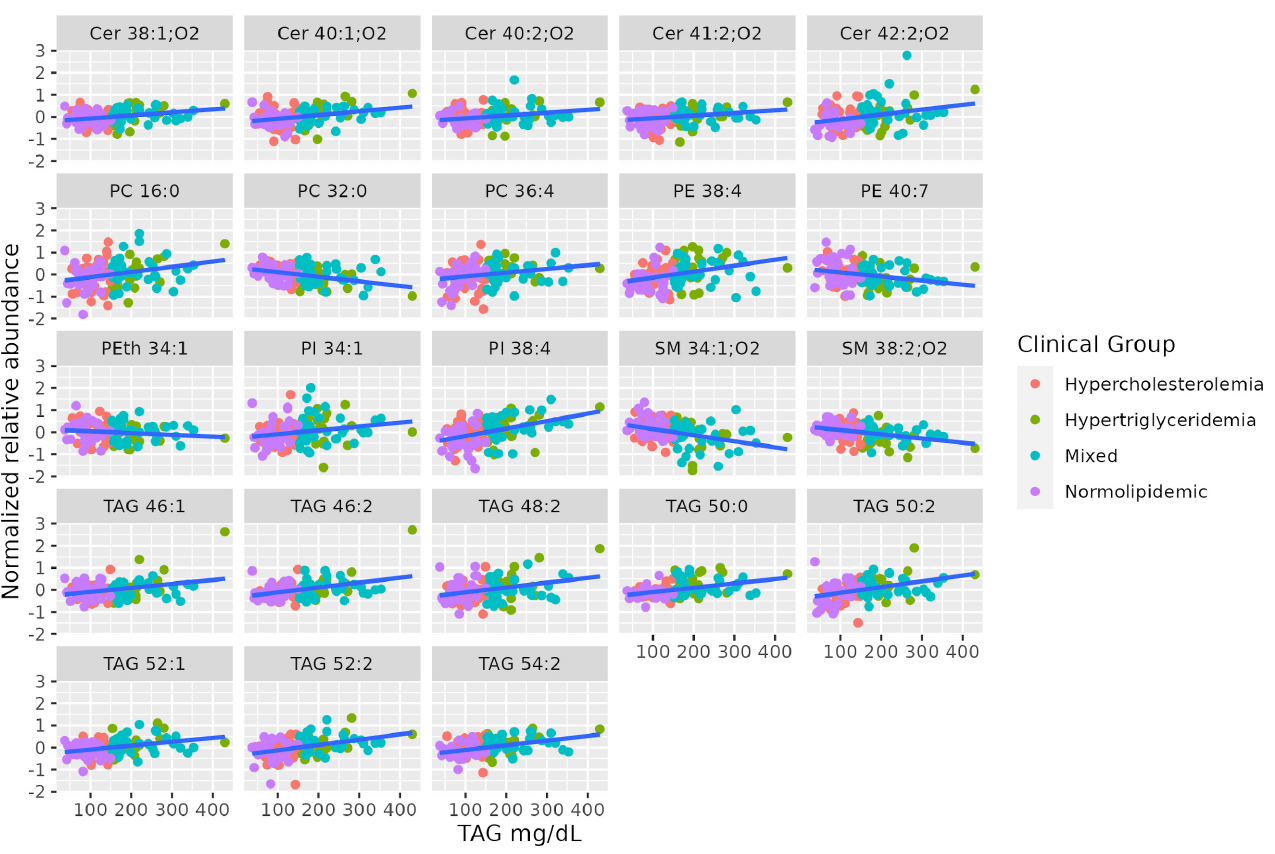
Figure 2. Dot-plot representing the correlation profile between serum TAG levels and the MS-annotated lipid classes. A line obtained by simple linear regression was added to aid visualization.